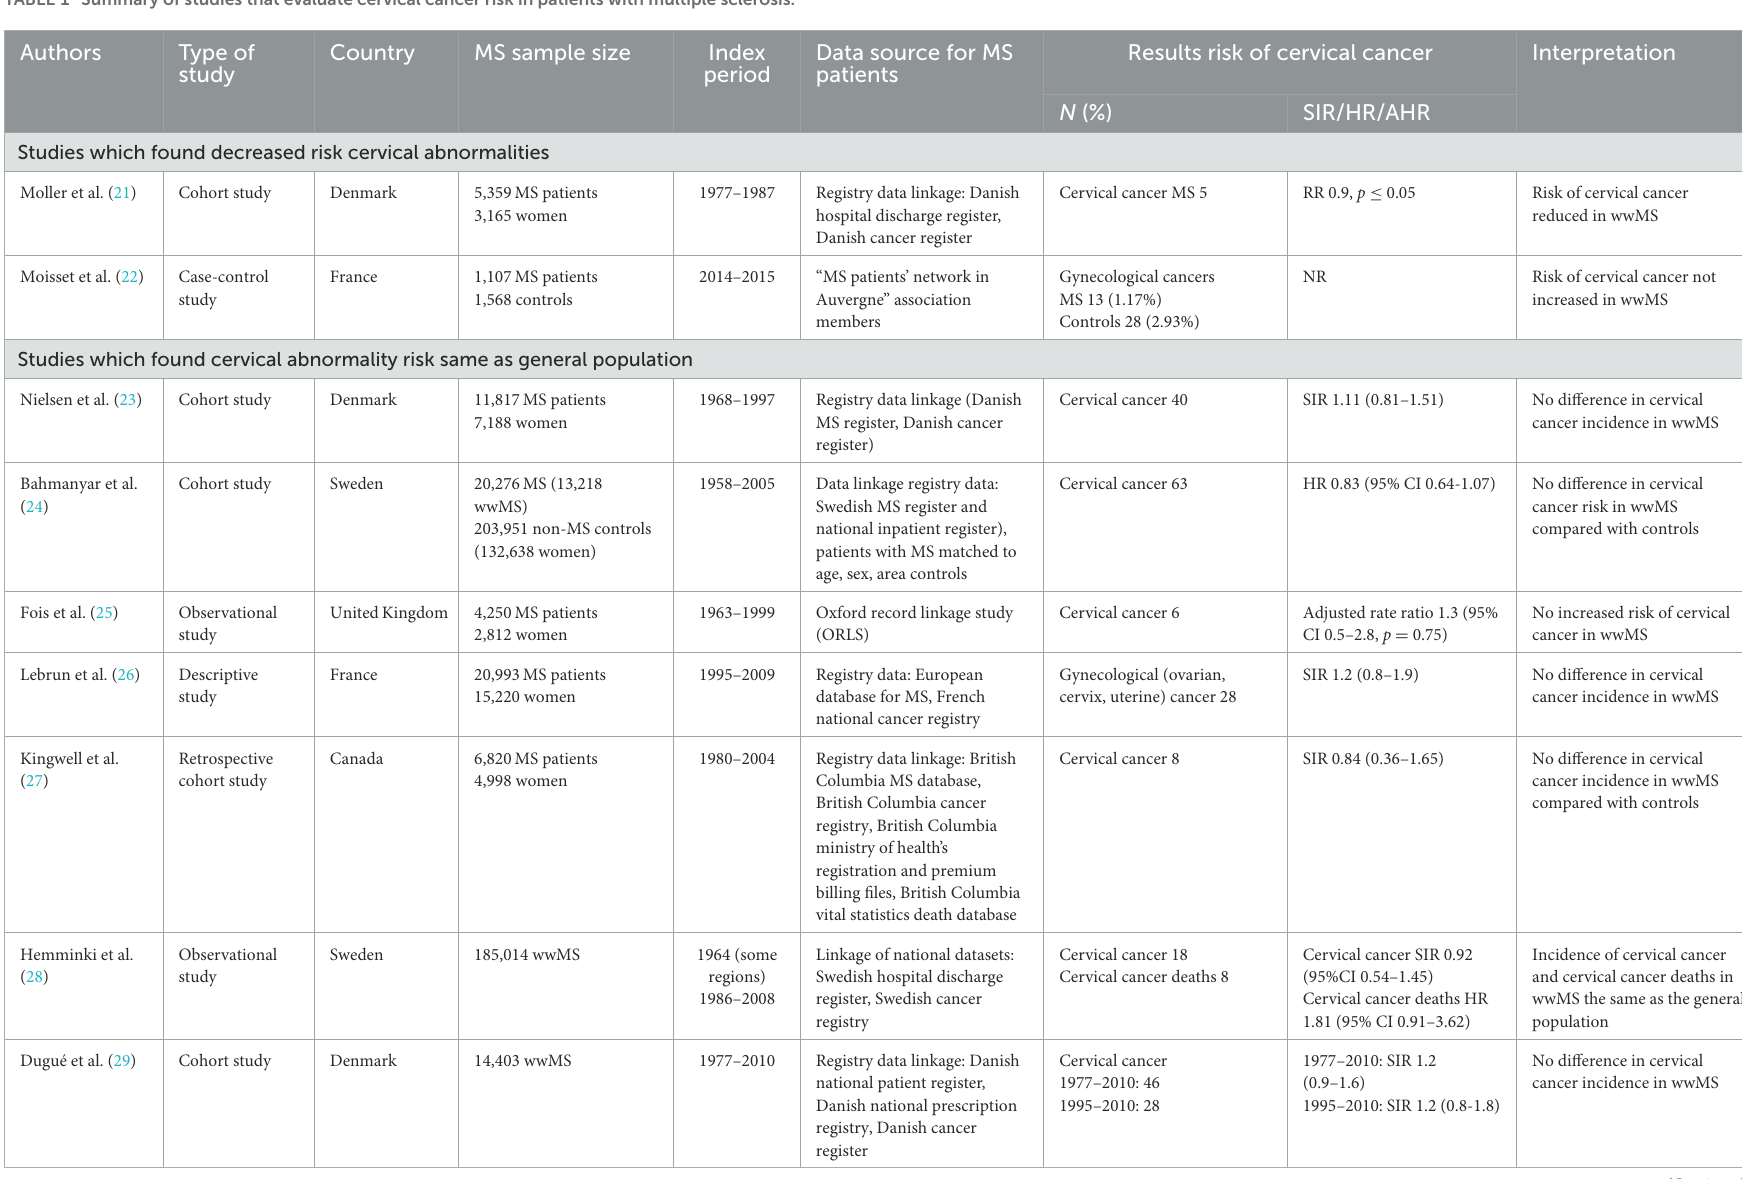
TABLE 1 Summary of studies that evaluate cervical cancer risk in patients with multiple